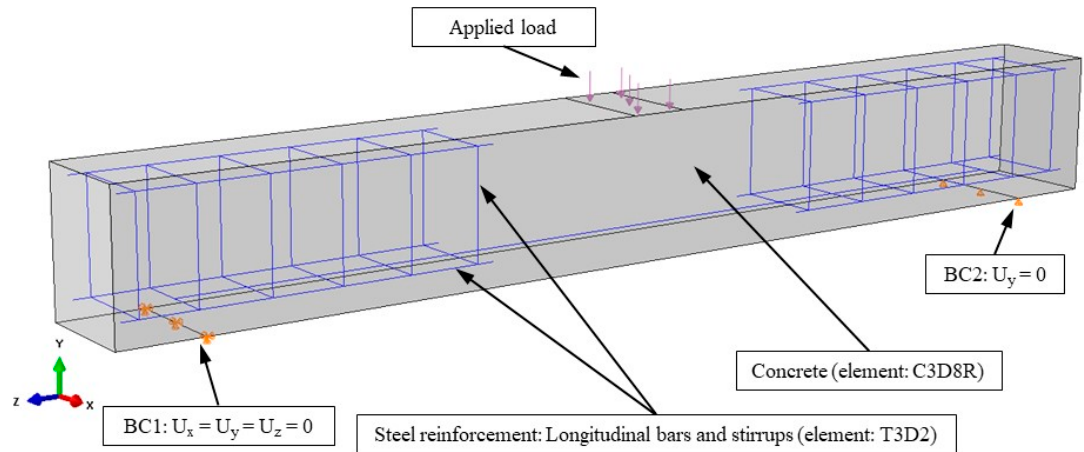
Figure 11. FEM boundary conditions, element types and applied load.